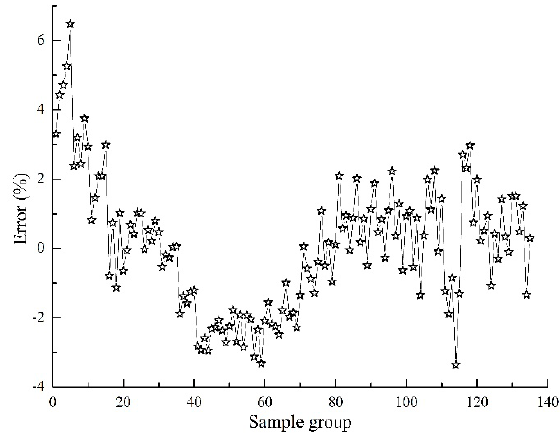
Figure 8. Prediction error of BP neural network.